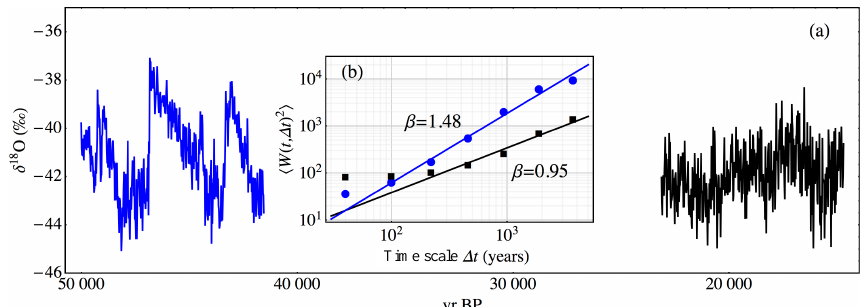
Figure 2. (a) The δ 18 O concentration in the NGRIP ice core. The data are given as 20-year mean values. Two different parts of the times series are shown. The blue curve represents the δ 18 O concentration in a time period starting approximately 50kyr before present (BP) and has a duration of approximately 8500 years. As in Fig. 1, present means AD 2000 ( = 2000CE). The black curve represents the δ 18 O concentration in a long stadial period that started about 22kyrsBP and has a duration of approximately 8500 years. (b) The wavelet scaling functions estimated from the two parts of the NGRIP data set. The blue points are the estimates from the part of the NGRIP ice core that is shown as a blue curve in (a) , and which contains DO cycles. The black points are the estimates from the part of the NGRIP ice core that is shown as a black curve in (a) , and which does not contain any DO